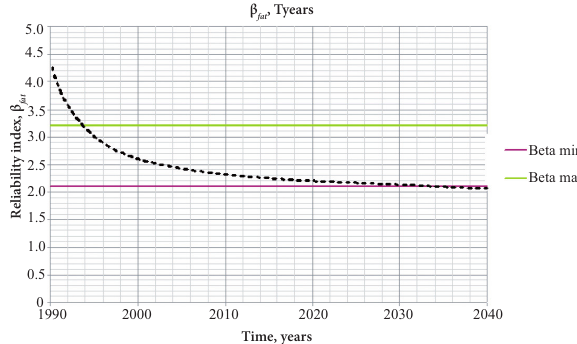
Fig. 10. Probabilistic modelling of the likelihood of failure, rivets of the short shear diaphragm connection – detail 2 (shear detail category according to EN 1993-1-9:2005 , C = 100) for a max stress excursion of 77 MPa